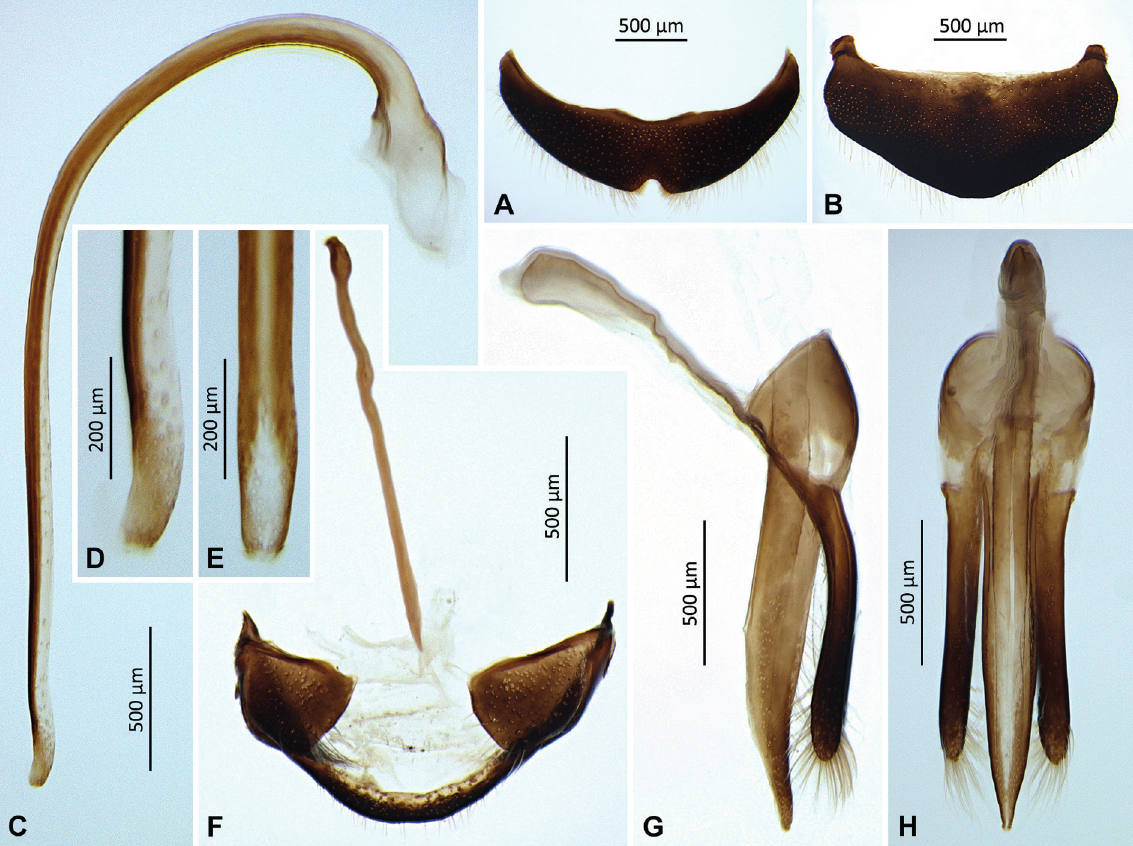
Fig. 11. Epilachna obtusiforma Gordon, 1975, ♂ (MIZ). A . Ventrite 6. B . Tergite VIII. C . Penis, lateral view. D . Penis tip, lateral view. E . Penis tip, inner view. F . Segments IX and X, dorsal view. G . Tegmen, lateral view. H . Tegmen, inner